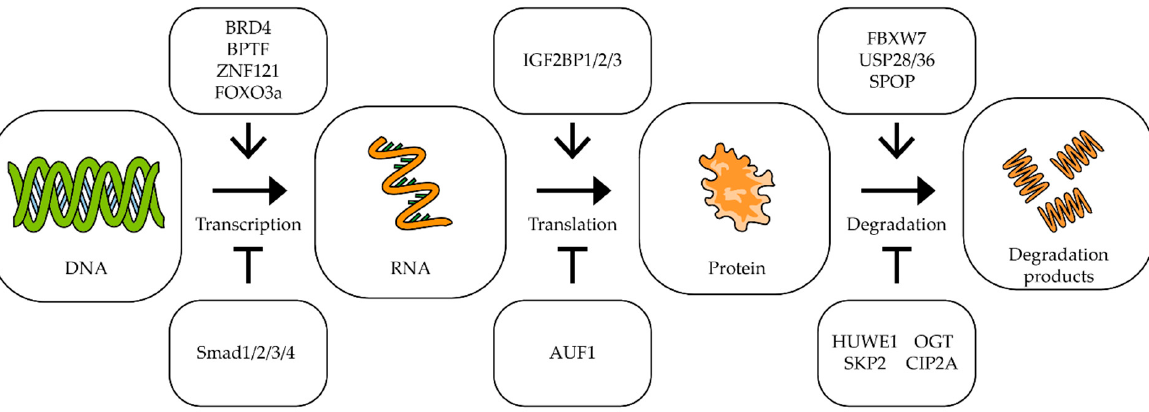
Figure 2. The impact of different factors on MYC transcription, translation and degradation. Schematic representation of influence of different factors on MYC transcription, translation, and c-Myc degradation. The upper/lower boxes indicate factors that activate/inhibit transcription, translation, or protein degradation (see text for description and references).